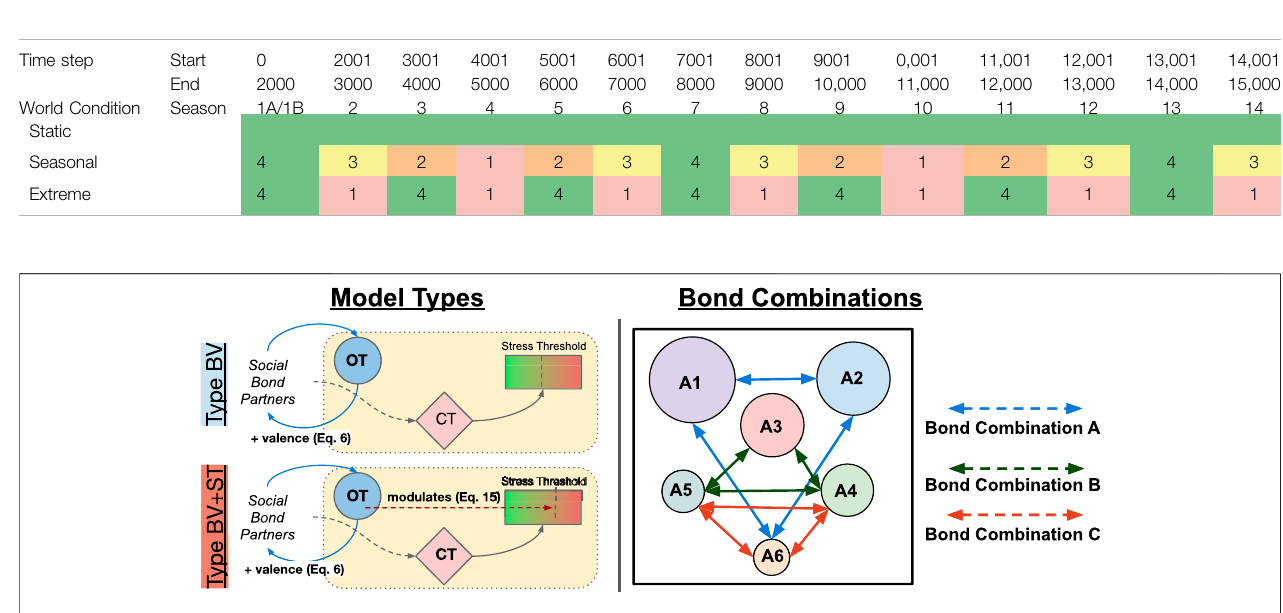
FIGURE6| Left:Thetwodifferentmodeltypesinvestigatedinourexperiments.Right:Thethreedifferentcombinationsofagentsthatsharedaffectivesocialbonds (Bond Combinations). Arrows between agents indicate agents that shared an affective social bond in each condition.